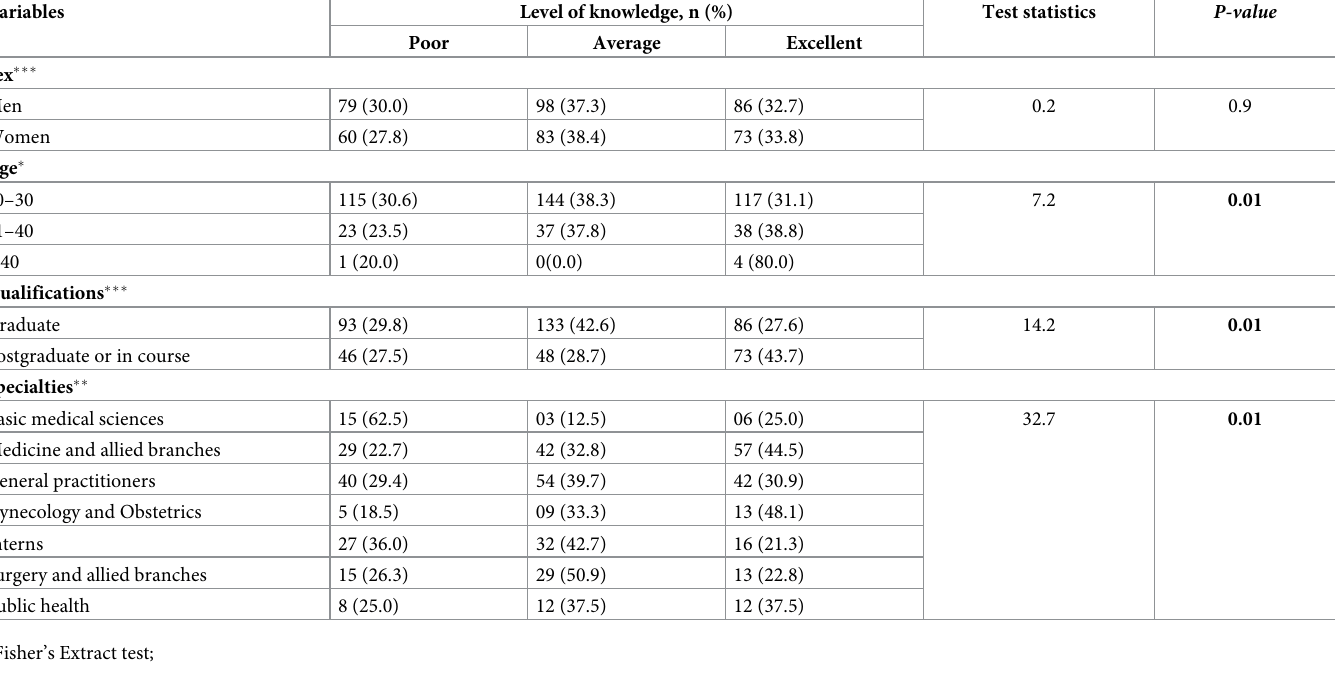
Table 3. Level of knowledge about palliative care based on demographic characteristics (n =